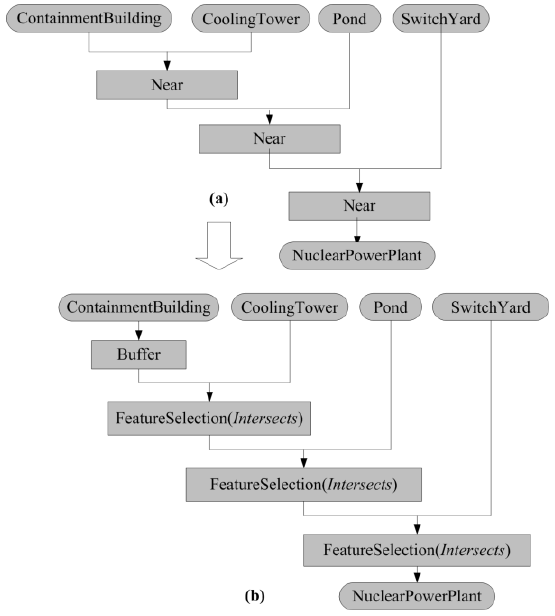
Figure 1. Example of a complex feature